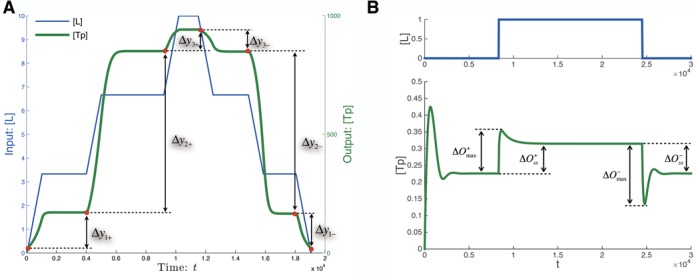
Sample fitness functions for selection for networks with ultrasensitive or adaptive response dynamics. (A) The input signal (blue) used in the temporal simulations of the system for ultrasensitivity. Each ramp-up and ramp-down of the signal is introduced after the system reaches steady state. The corresponding system output over time is shown in green. The differences in steady state output between different signal levels, indicated as Δy values on the plot, are used to calculate the amplitude and ultrasensitivity scores. (B) Illustration of the dynamics of input signal (blue) the output response (green) in simulations of the system for adaptive dynamics. The parameters in adaptive fitness function, \documentclass[12pt]{minimal}
\usepackage{amsmath}
\usepackage{wasysym}
\usepackage{amsfonts}
\usepackage{amssymb}
\usepackage{amsbsy}
\usepackage{upgreek}
\usepackage{mathrsfs}
\setlength{\oddsidemargin}{-69pt}
\begin{document}
}{}$\Delta O_{max}^{ + / - }$\end{document} and \documentclass[12pt]{minimal}
\usepackage{amsmath}
\usepackage{wasysym}
\usepackage{amsfonts}
\usepackage{amssymb}
\usepackage{amsbsy}
\usepackage{upgreek}
\usepackage{mathrsfs}
\setlength{\oddsidemargin}{-69pt}
\begin{document}
}{}$\Delta O_{ss}^{ + / - }$\end{document}, are labeled.